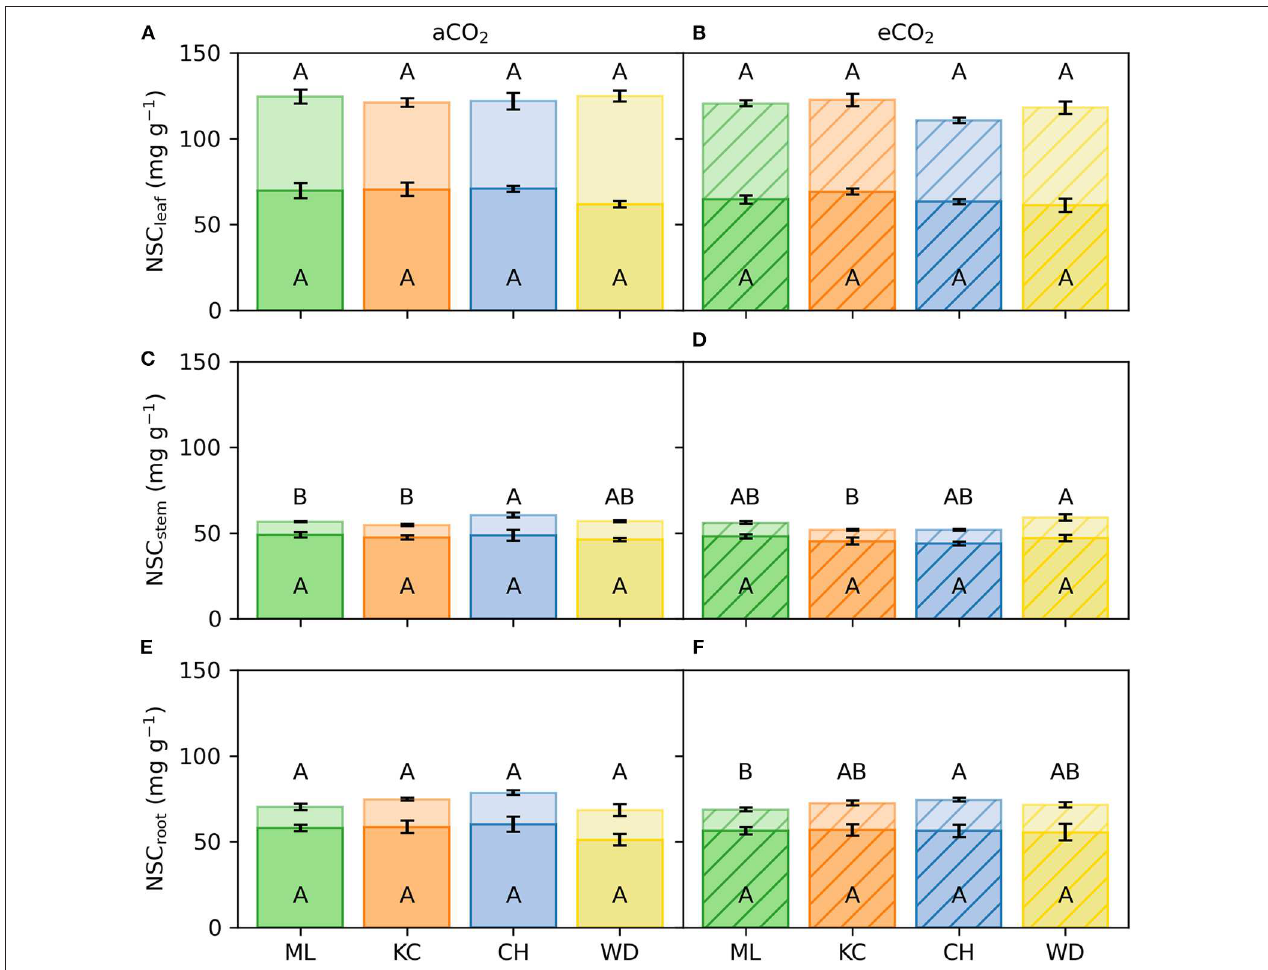
FIGURE 4 | Non-structural carbohydrates (NSC) in three tissues of E. grandis . Samples were collected at the final harvest. Data are shown for ambient [CO 2 ] treatment (aCO 2 ; left ; n = 5) and elevated [CO 2 ] treatment (eCO 2 ; right ; n = 5). NSC are presented for two fractions: soluble sugars (ss; light colored area) and starch (st; full colored area) in leaves (NSC leaf ; A,B ), stem (NSC stem ; C,D ) and roots (NSC root ; E,F ). Error bars represent 1SE. Colors and abbreviations represent different provenances. Different capital case letters represent statistical significance of ss or st, respectively, among provenances within the same [CO 2 ] treatment.